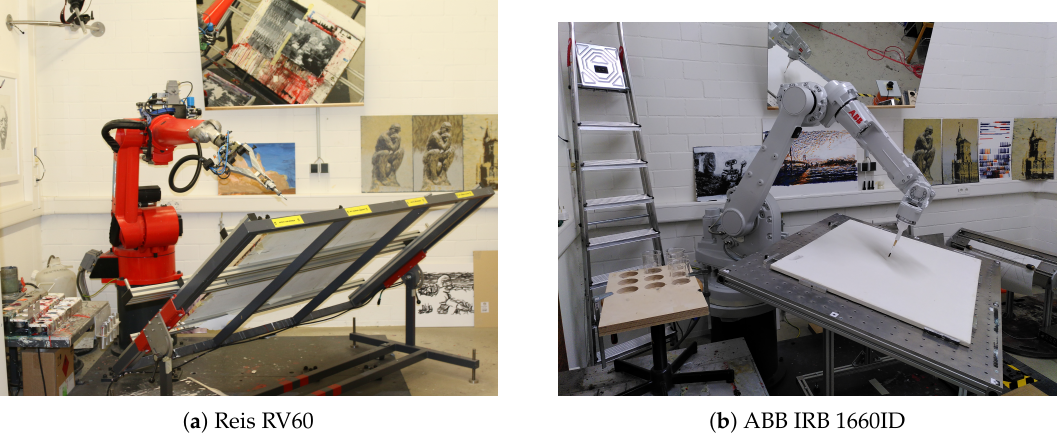
Figure 1. The robots in the